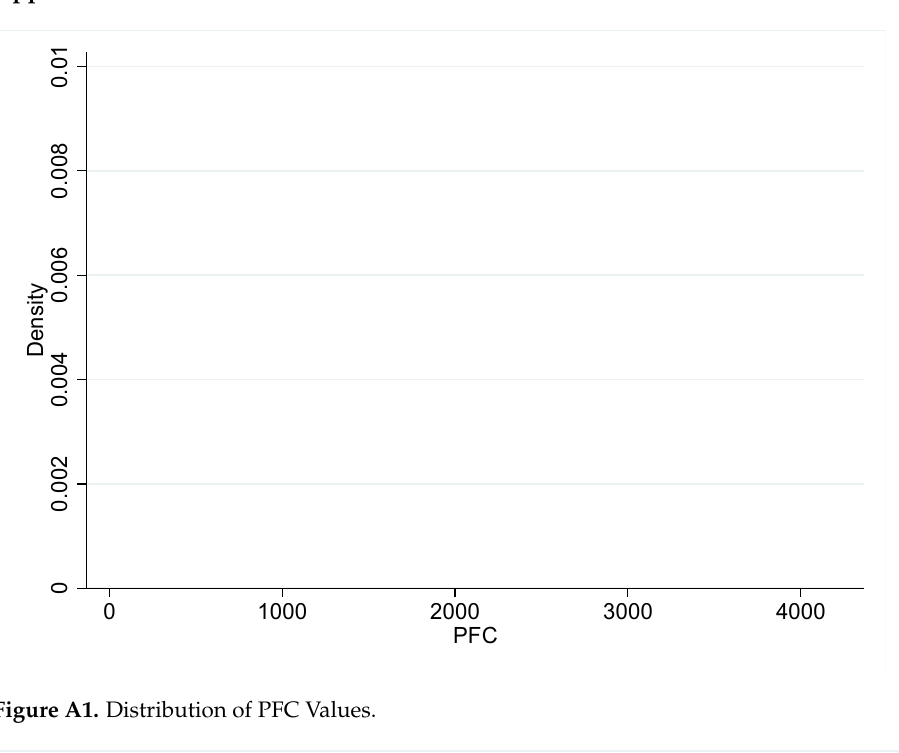
Figure A1. Distribution of PFC Values.